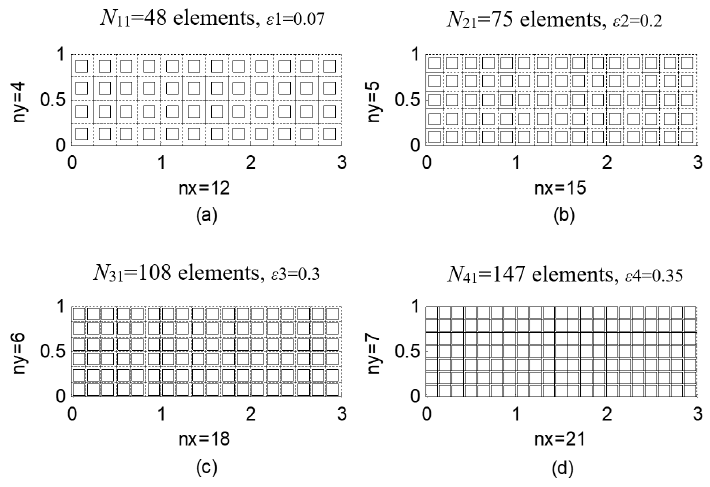
Figure 1. A ground elements set for MOP1, MOP3, and MOP4 ( a ) for n = 1; ( b ) for n = 2; ( c ) for n = 3, and ( d ) for n = 4.